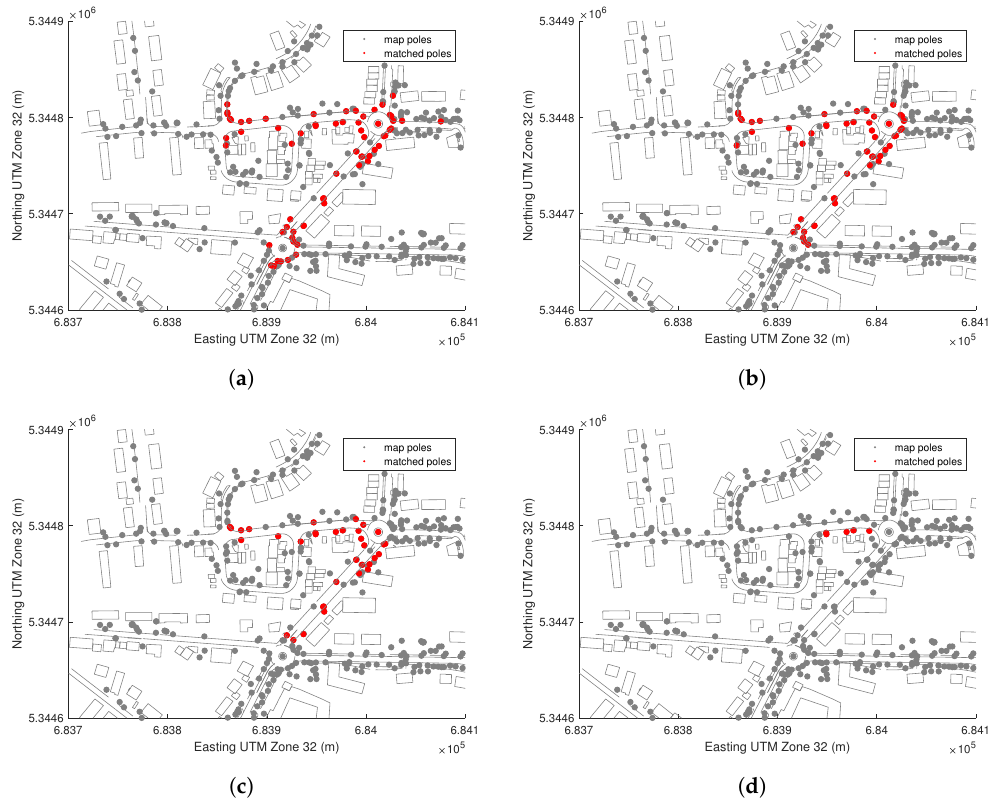
Figure 9. Example for the number of matched pole landmarks with different levels of range limitation for detections. The red dots are the matched landmarks over the course of Test Drive 02, whereas the grey dots and lines represent the HD map. ( a ) Baseline. ( b ) Maximum range 30 m. ( c ) Maximum range 20 m. ( d ) Maximum range 10